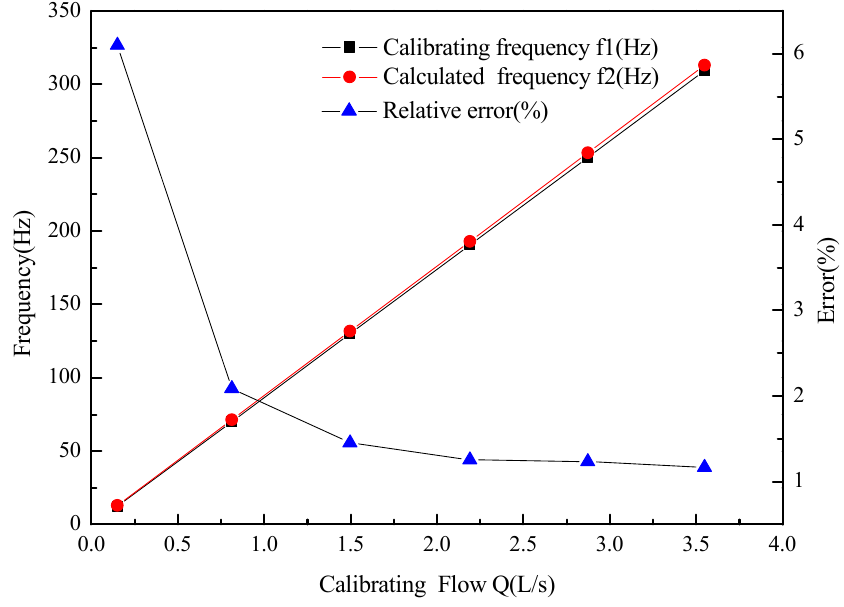
Figure 5. The validation of DN20 Turbine flow sensor model.